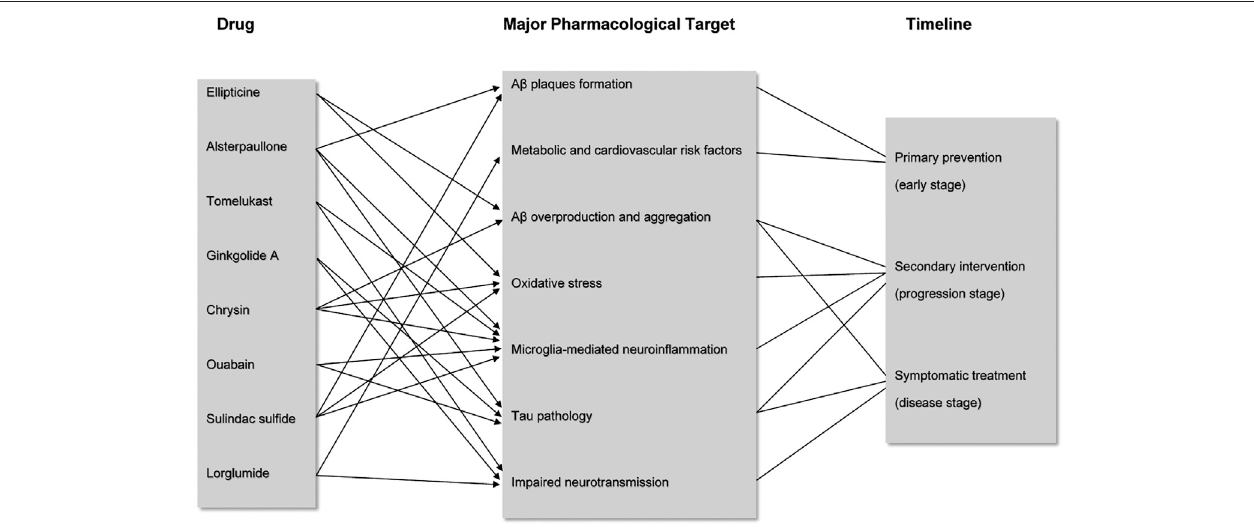
FIGURE 2 | Major pharmacological targets of the eight candidate drugs during AD progression. Candidate drugs are each associated with several major targets involved indifferenttimepointsofADprogression.Arrows and linesshow thecorrelation betweendrugand pharmacological targets basedon theliterature evidence, as well as the correlation between targets and disease progression